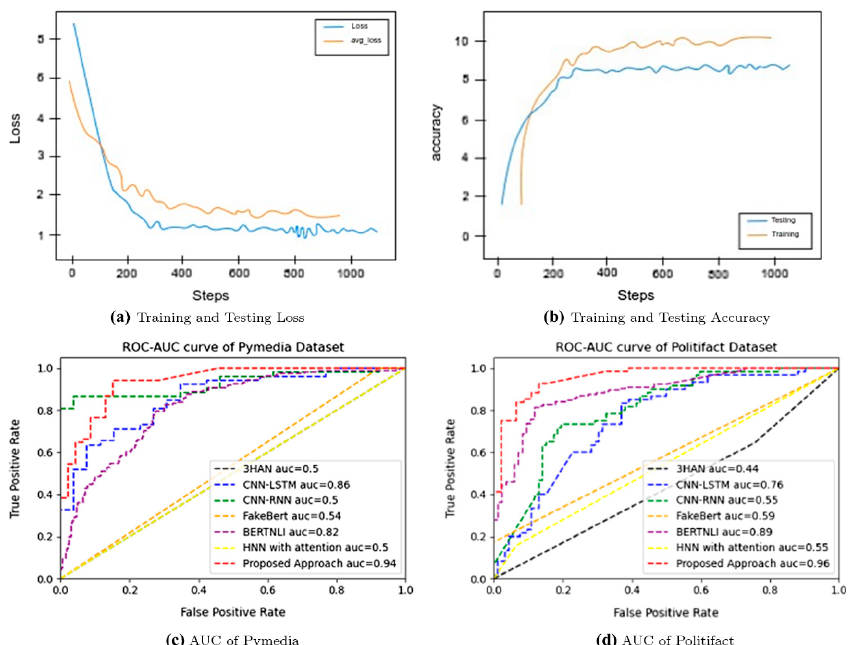
Figure 7. ( a ) Loss in training and testing (Pymedia dataset). ( b ) Accuracy in training and testing (Politifact dataset). ( c ) Results of ROC-AUC curves (dataset from Pymedia). ( d ) Results of ROC-AUC curves (dataset from Politifact).